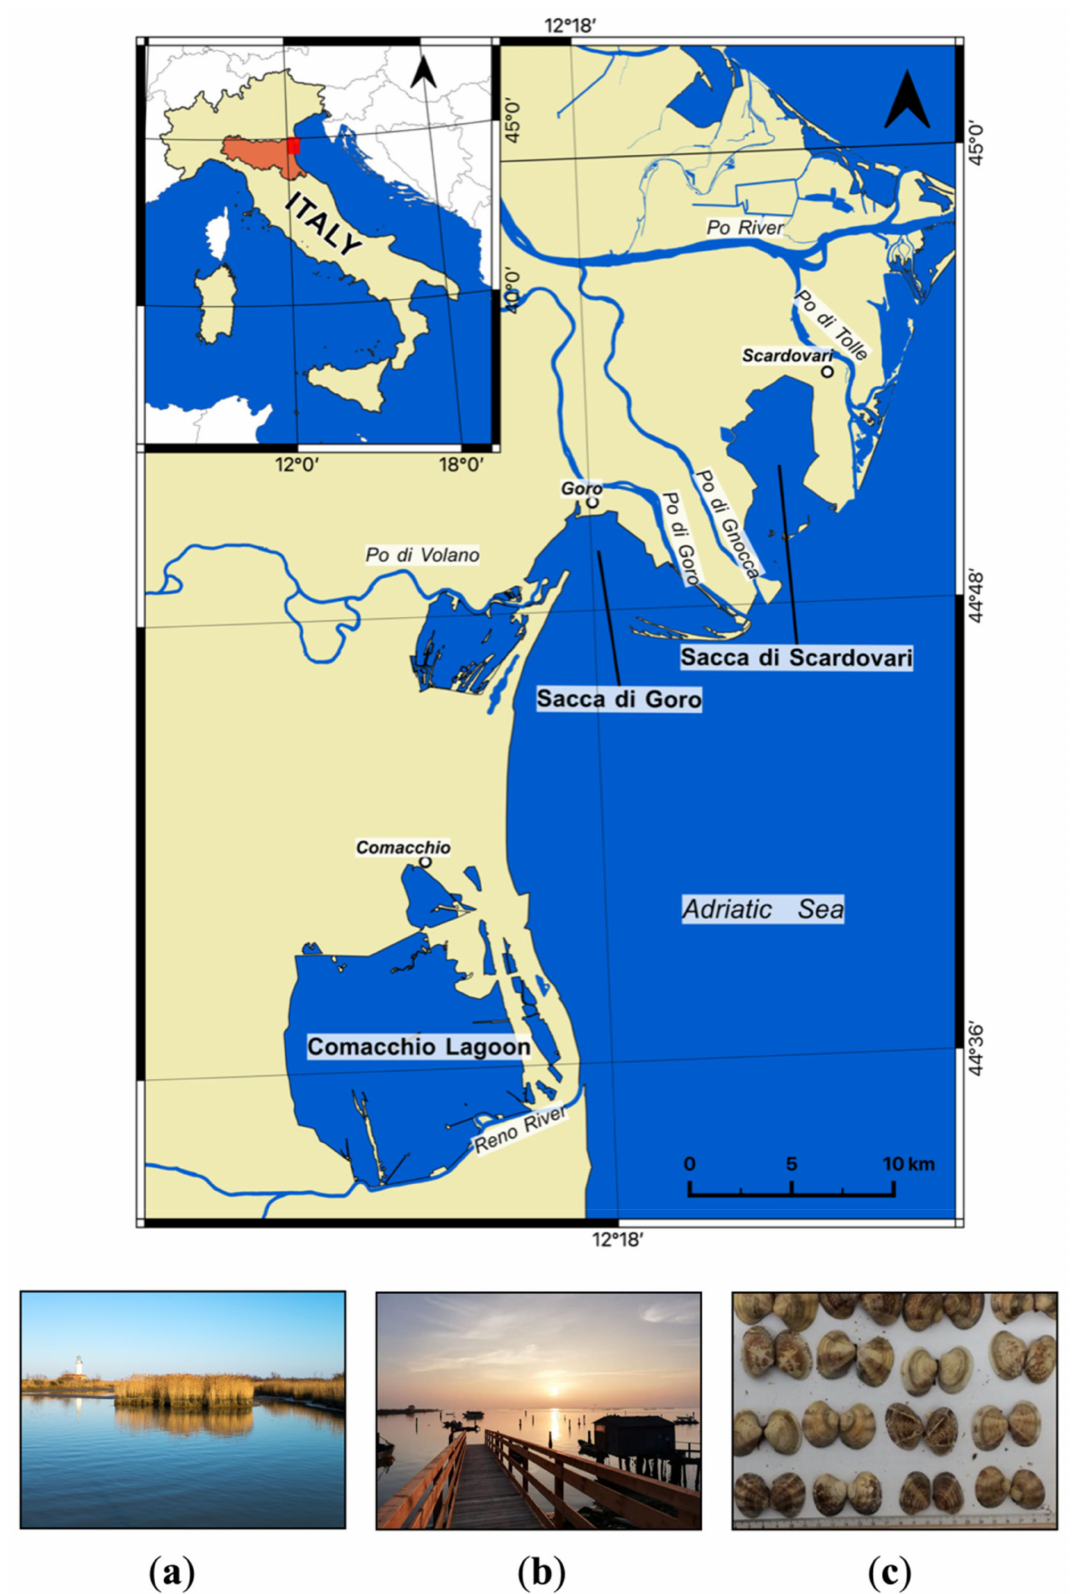
Figure 1. Geographic setting and locations of the investigated lagoons within the Po river delta area along the north-western Adriatic coast of the Emilia-Romagna and Veneto regions (Italy). Photos of ( a ) Sacca di Goro; ( b ) Sacca di Scardovari; and ( c ) Manila clams from Sacca di